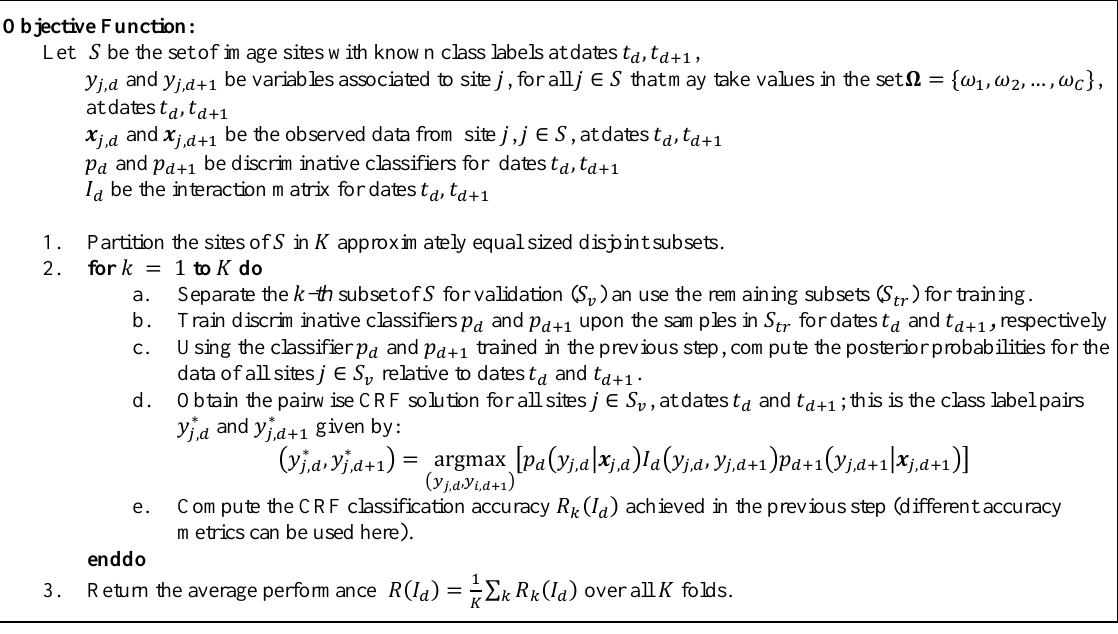
Figure 1: Methodology proposed to calculate the objective function 𝑅